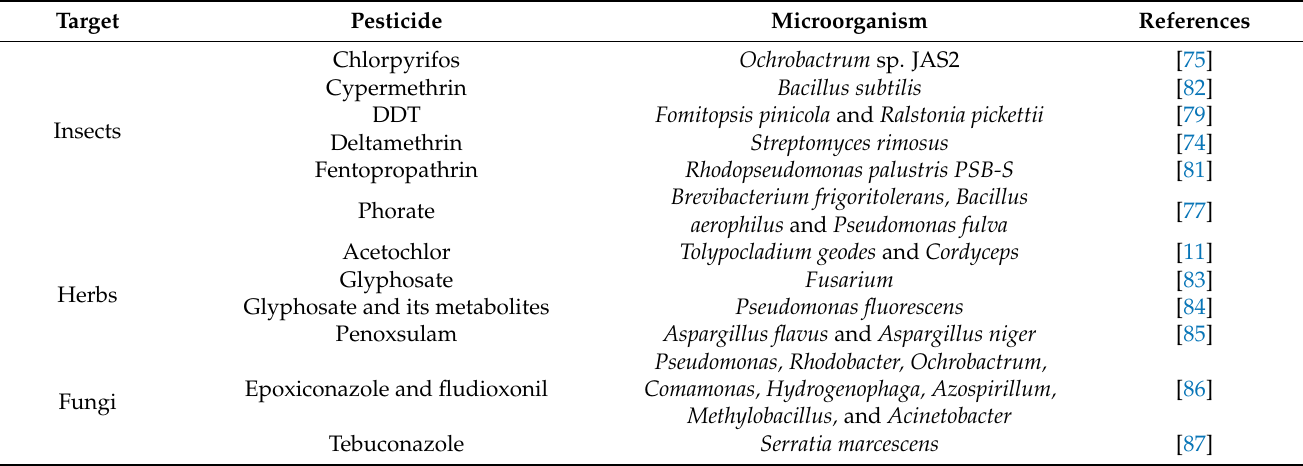
Table 8. Microorganisms capable to degrade several